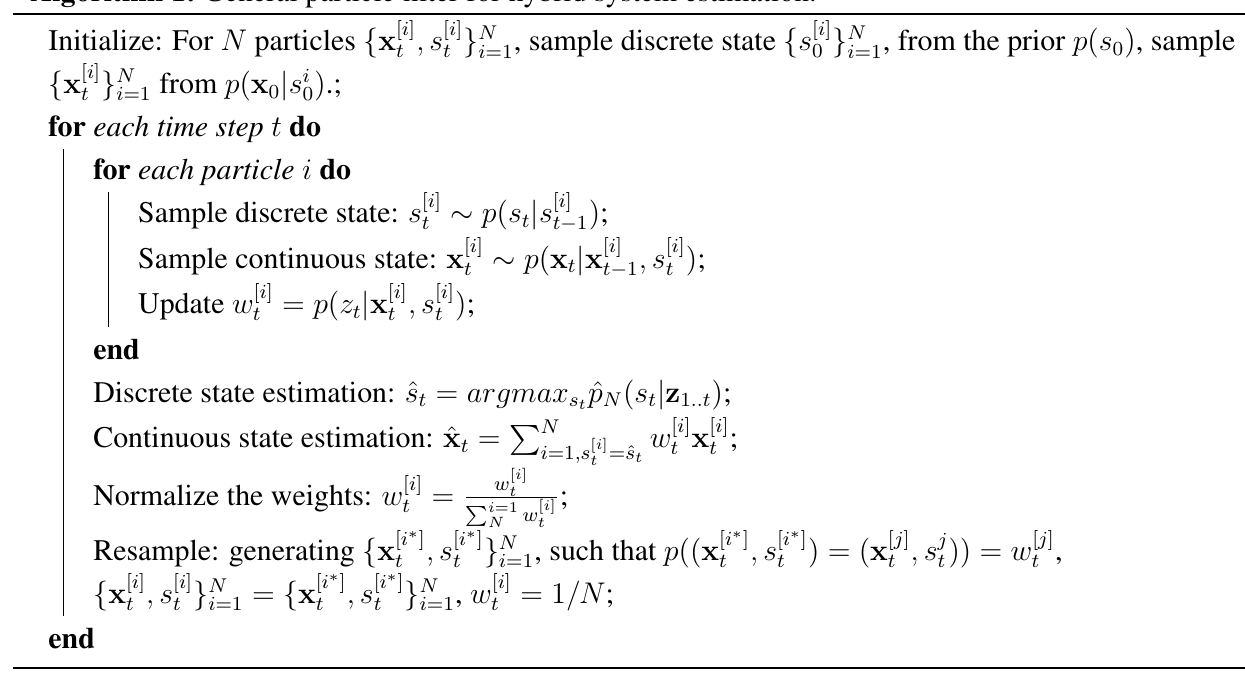
Algorithm 1: General particle filter for hybrid system